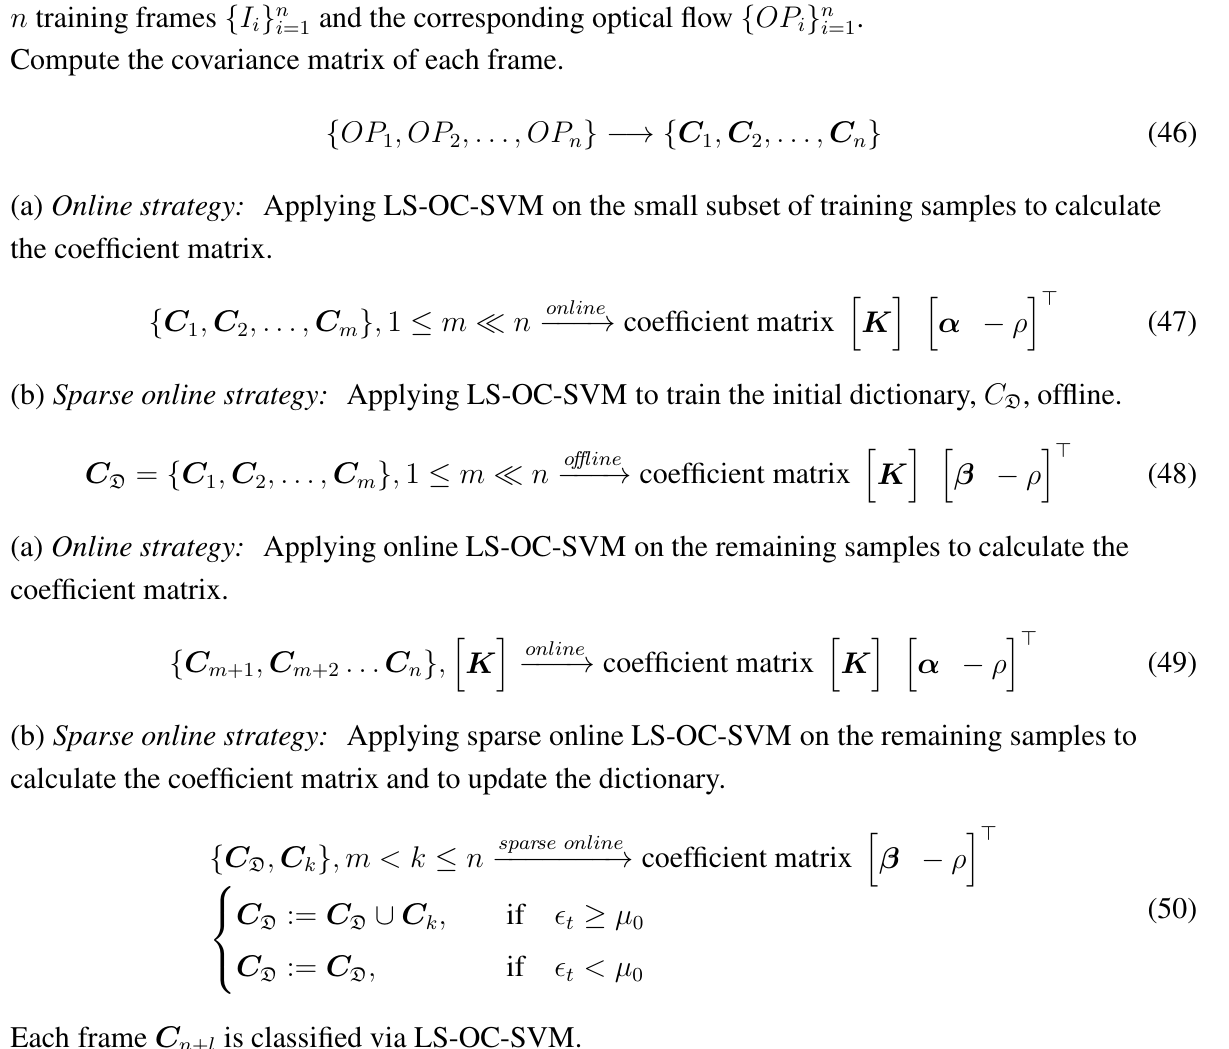
Algorithm 1: Visual abnormal event detection via online least squares one-class support vector machine (LS-OC-SVM) and sparse online LS-OC-SVM.